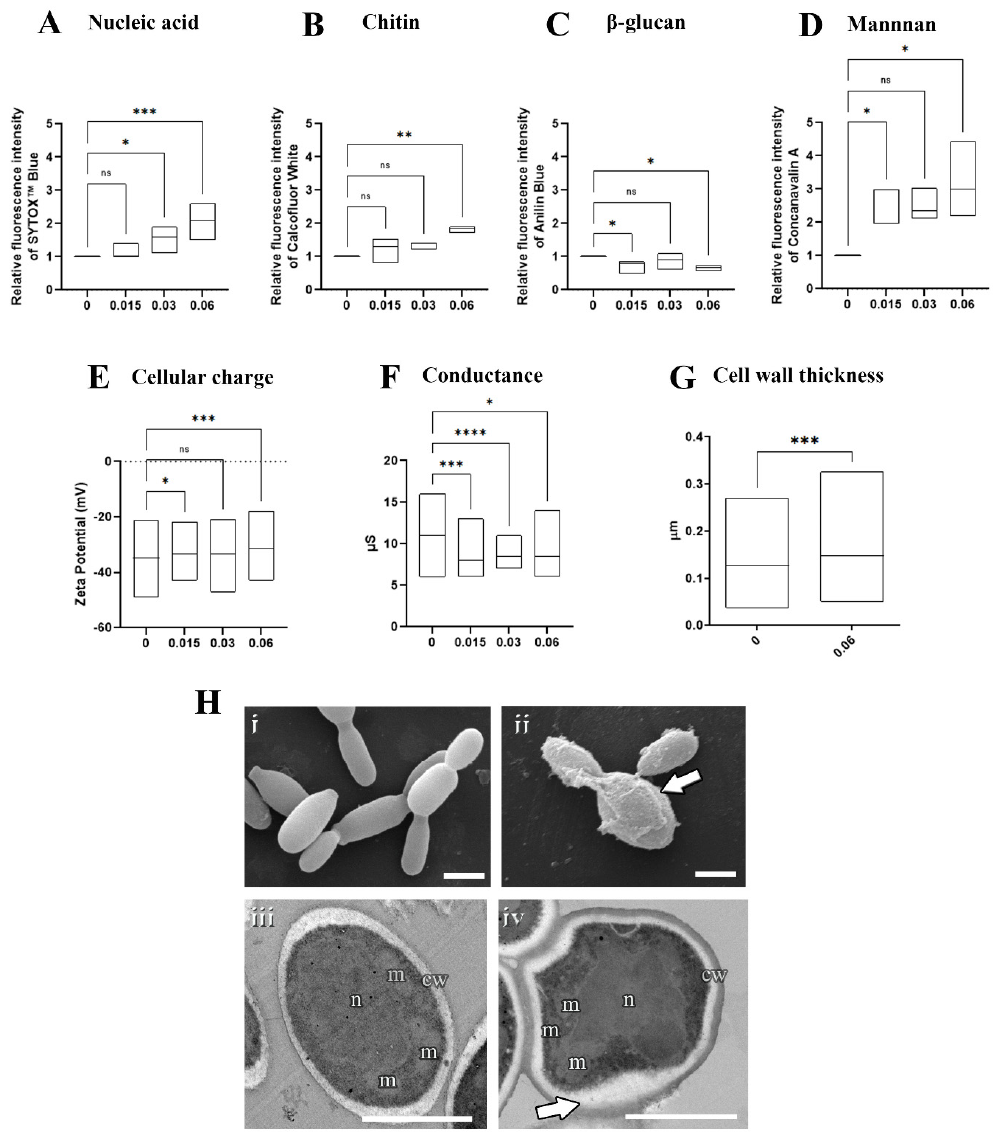
Figure 3. Effects of olorofim exposure on S. brasiliensis yeasts. Treated yeasts analyzed by fluorimetry exhibited a dose − dependent DNA accumulation ( A ), increased chitin ( B ), decreased β − glucan ( C ), increased mannan ( D ), and reduced electronegativity ( E ) and conductance ( F ). Cell wall measurements revealed that olorofim treatment increased the thickness of this structure ( G ).